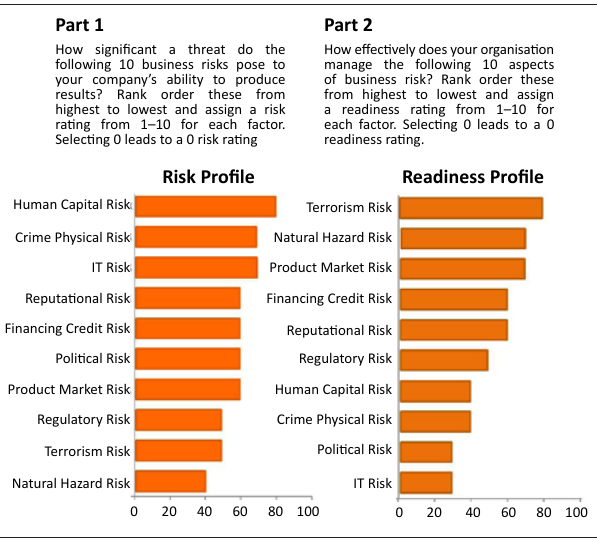
FIGURE 1: Types of risks the Human Capital Institute (Africa)